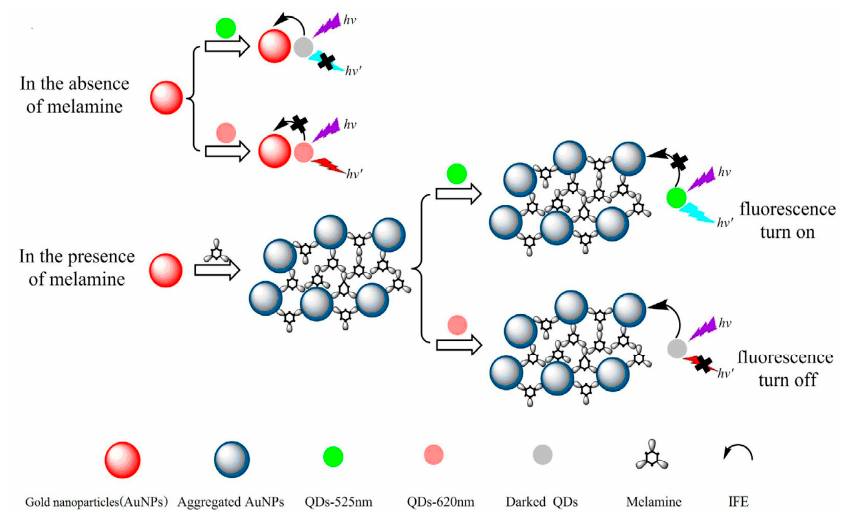
Figure 13. Schematic illustration of the dual-mode fluorescent probe for melamine detection (reproduced with the permission of Reference [89]).